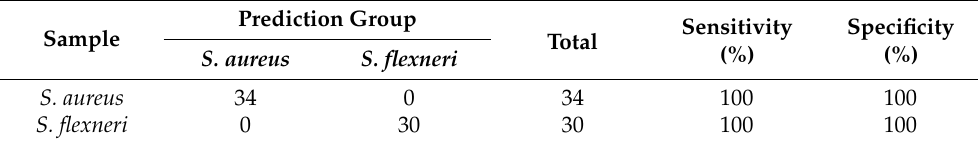
Table 1. PC-LDA classification results of S. aureus and S. flexneri